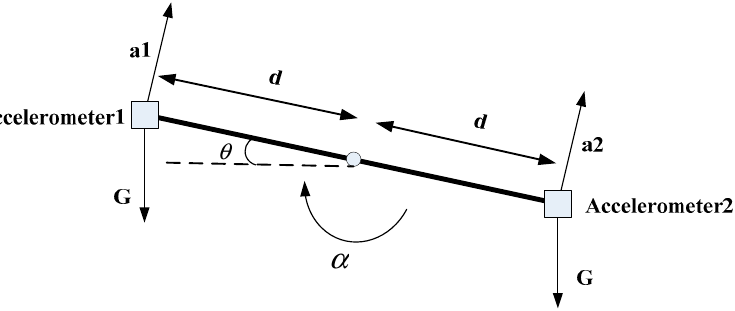
Figure 3. Schematic diagram of the installation of the linear accelerometer.